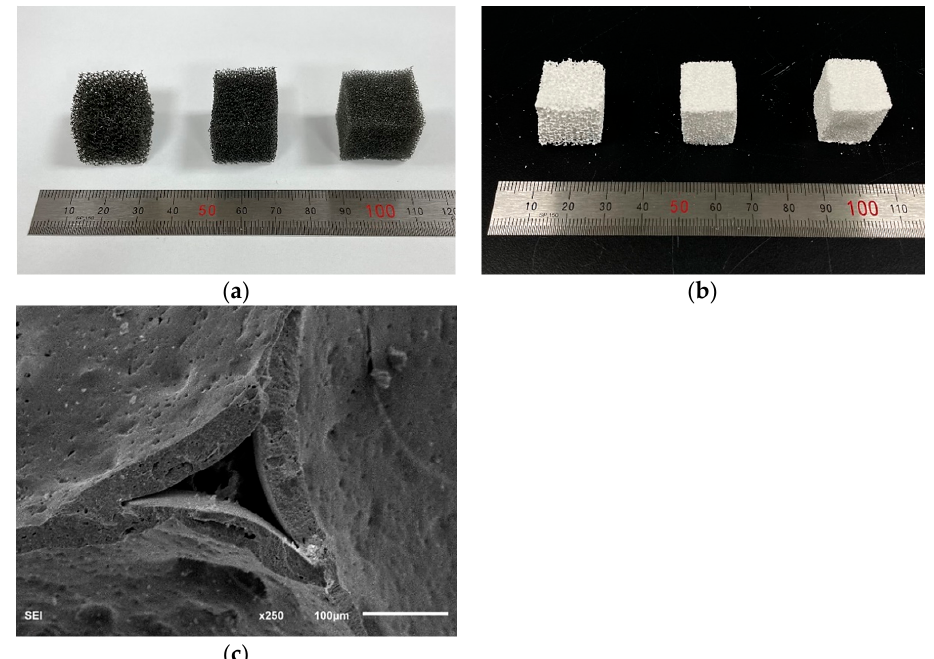
Figure 1. Optical images of ( a ) sacrificial polymer templates with pore densities of 25, 45 and 60, ( b ) reticulated porous ZTA specimens with corresponding pore densities of 25, 45 and 60, and ( c ) typical scanning electron microscopy image of the fractured strut wall of a reticulated porous ZTA specimen.